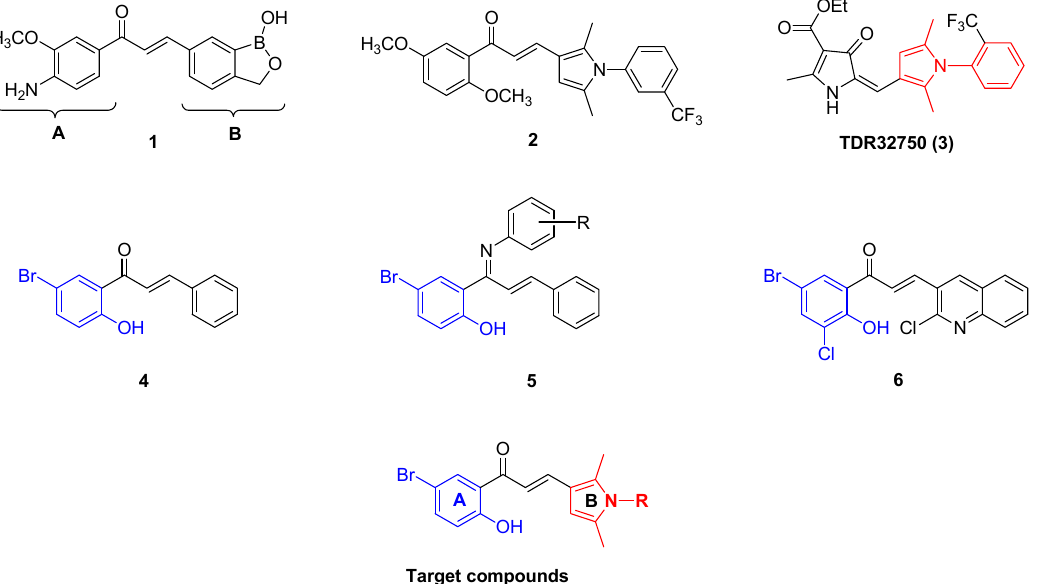
Figure 2. Examples of some bioactive chalcone derivatives, arylpyrroles, and target